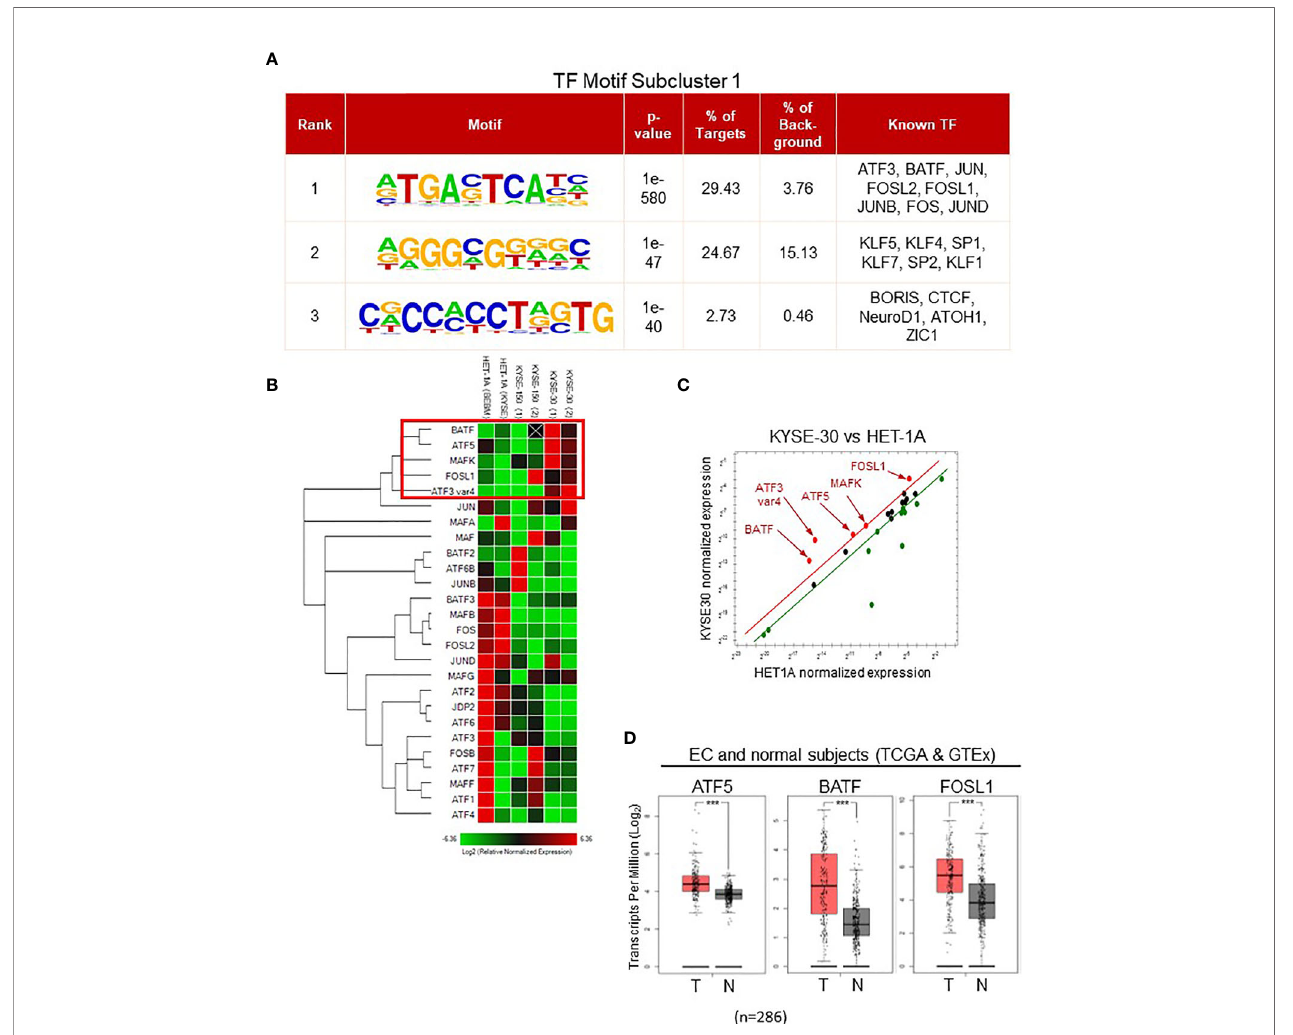
FIGURE 5 | Identi fi cation of AP-1 family in subcluster 1 by transcription factor motif analysis. (A) All ATAC-seq peaks in subcluster 1 were analyzed, and the potential transcription factors bound to the DNA and their sequence motifs were displayed in rank. (B) PCR array with probes targeting all AP-1 family member was performed. Heatmap displayed the RNA expression-based clustering of AP-1 family genes in HET1A, KYSE150, and KYSE30 cells. Genes in a red rectangle represented the upregulated genes in KYSE30 cells. HET-1A cells were incubated in the BEBM base medium [HET-1A (BEBM)] or identical medium for KYSE cells [HET-1A (KYSE)] overnight before RNA collection while KYSE-150 and -30 cells were cultured in identical conditions. (C) Signi fi cantly upregulated genes in KYSE-30 (red) versus HET-1A cells are shown in red. Green dots represent the downregulated genes. (D) ATF5, BATF, and FOSL1 gene expressions in tumors (T) were higher than that in neighboring tissues of EC patients or normal esophagus (N). T = 182, N = 286; Log2FC >0.5; *** p -value <